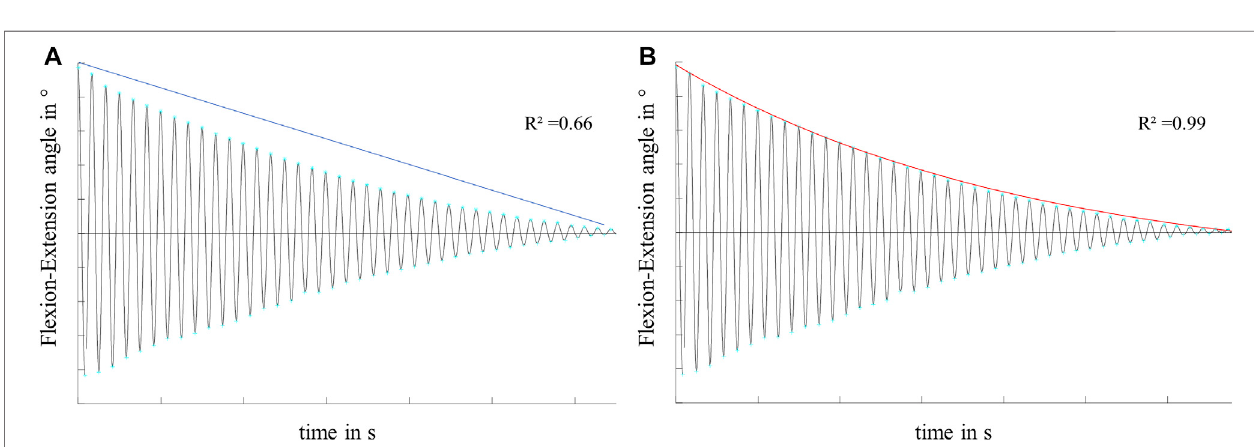
FIGURE 4 | Exemplary fl exion-extension data in the sagittal plane of a knee joint motion, characterized by a non-linear decay over time. Illustration and exemplary values for the goodness of fi t ( R 2 ) of (A) the linear decay function of the boundary friction model (Stanton, 1923) and (B) the exponential decay function of the viscous friction model (Crisco et al., 2007) on the decaying